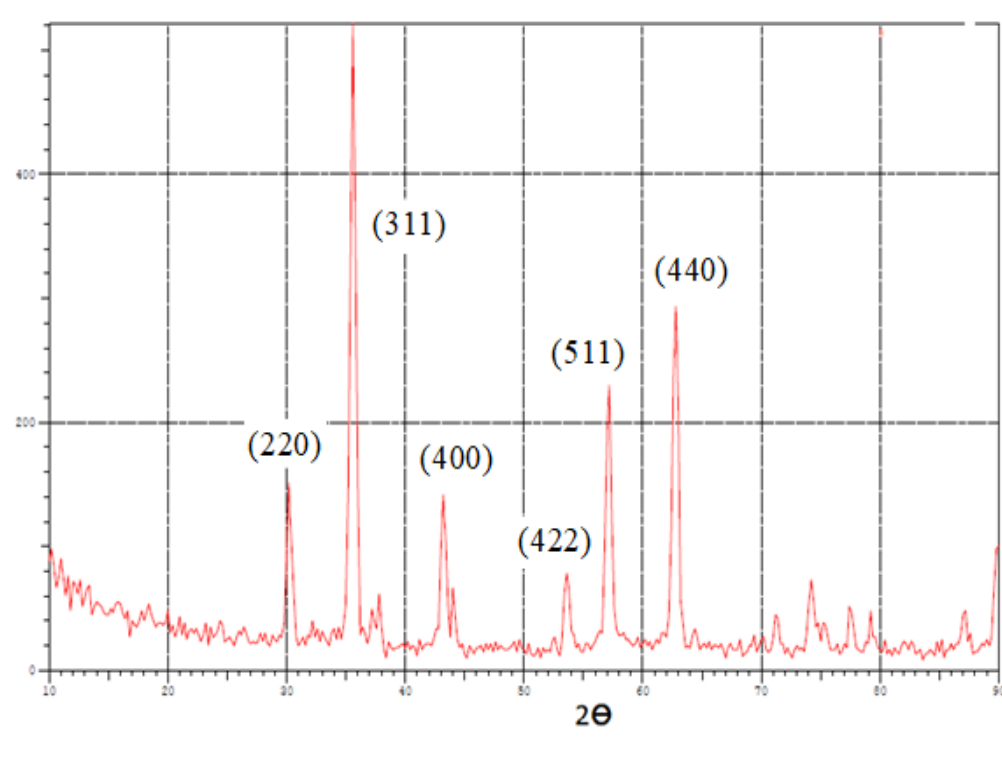
Figure 3. XRD of Fe 3 O 4 /CA.